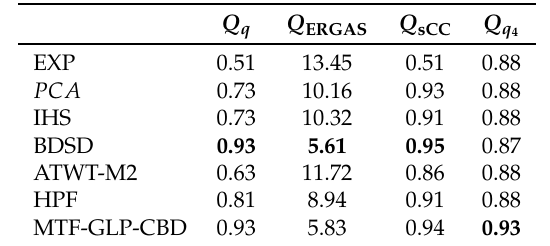
Table 4. IKONOS Roma Villa scene, reduced resolution metrics quantitative results. IHS, intensity-hue-saturation; BDSD, band-dependent spatial detail; ATWT-M2, a trous wavelet transform using Model 2; HPF, high-pass filtering; MTF-GLP-CBD, modulation transfer function Laplacian pyramid with context-based decision. The bold number indicates the best performing PS method according to each quality